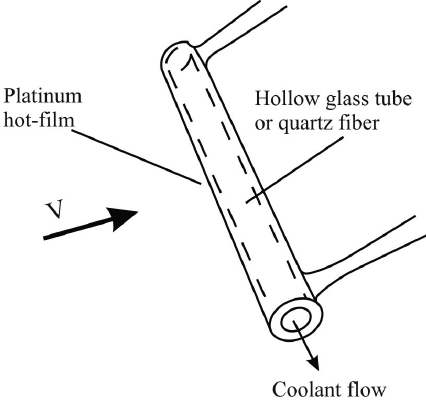
Figure 4. Tube thermo-anemometer diagram